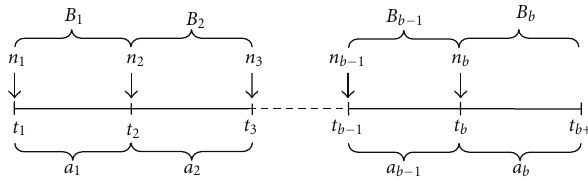
Figure 1: An outpatient clinical schedule with b